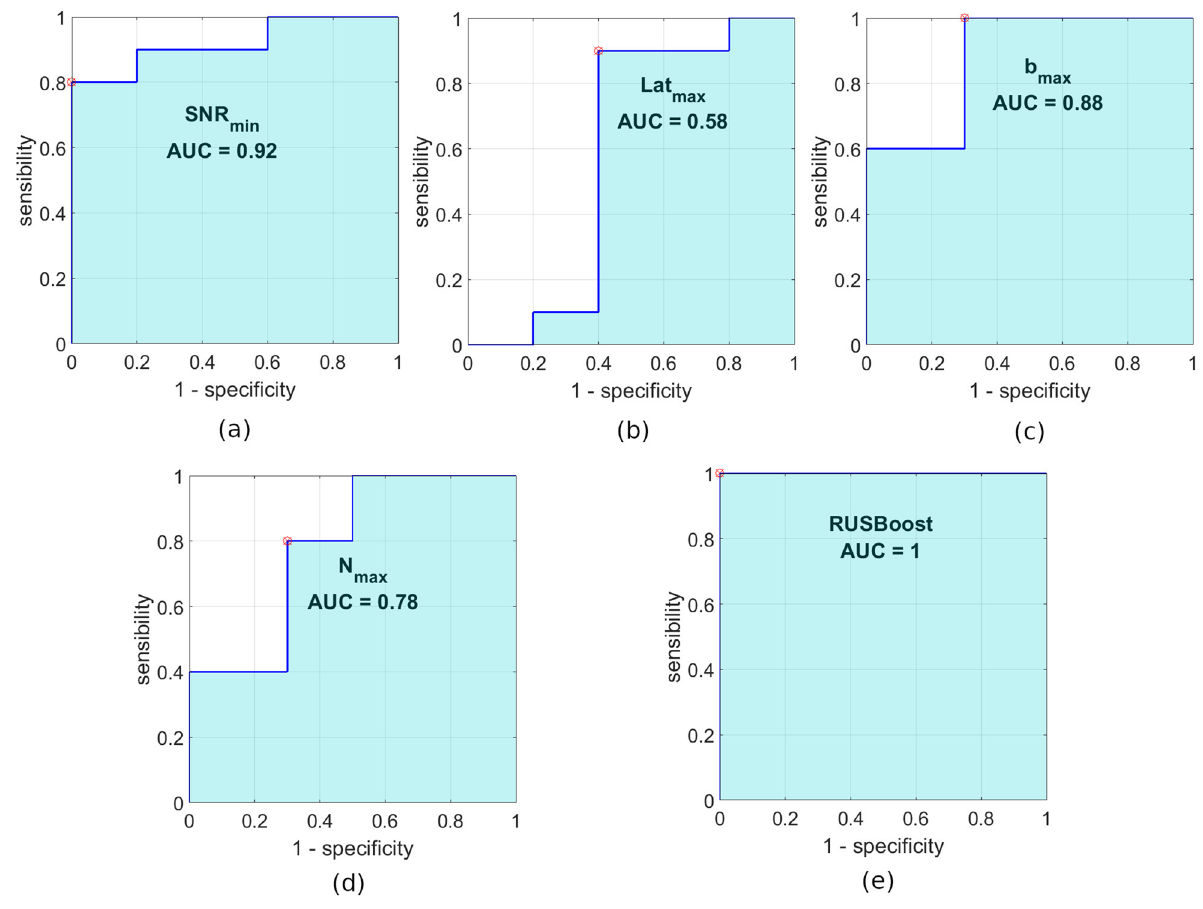
Figure 4. ROC graph of the variables and classifier. ( a ) ROC of SNR min . ( b ) ROC of Lat max . ( c ) ROC of b max . ( d ) ROC of N max . ( e ) ROC of the RUSBoosted Trees classifier. These images were generated using Matlab (Version: R2018b, Url: https ://www.mathw orks.com/produ cts/matla